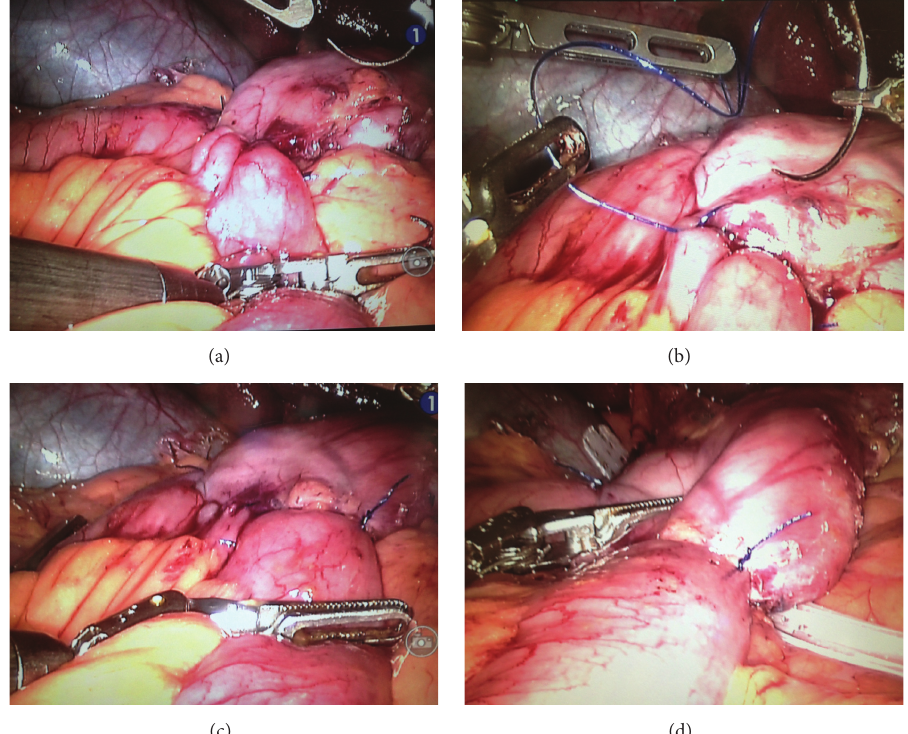
Figure 3: Duodenoileal anastomosis: anteriorlayer firstwith a vicryl continuous layer (a)and finally with a polypropylene 3/0 anterior closure (b). Anastomosis leak test (c). Drain placement